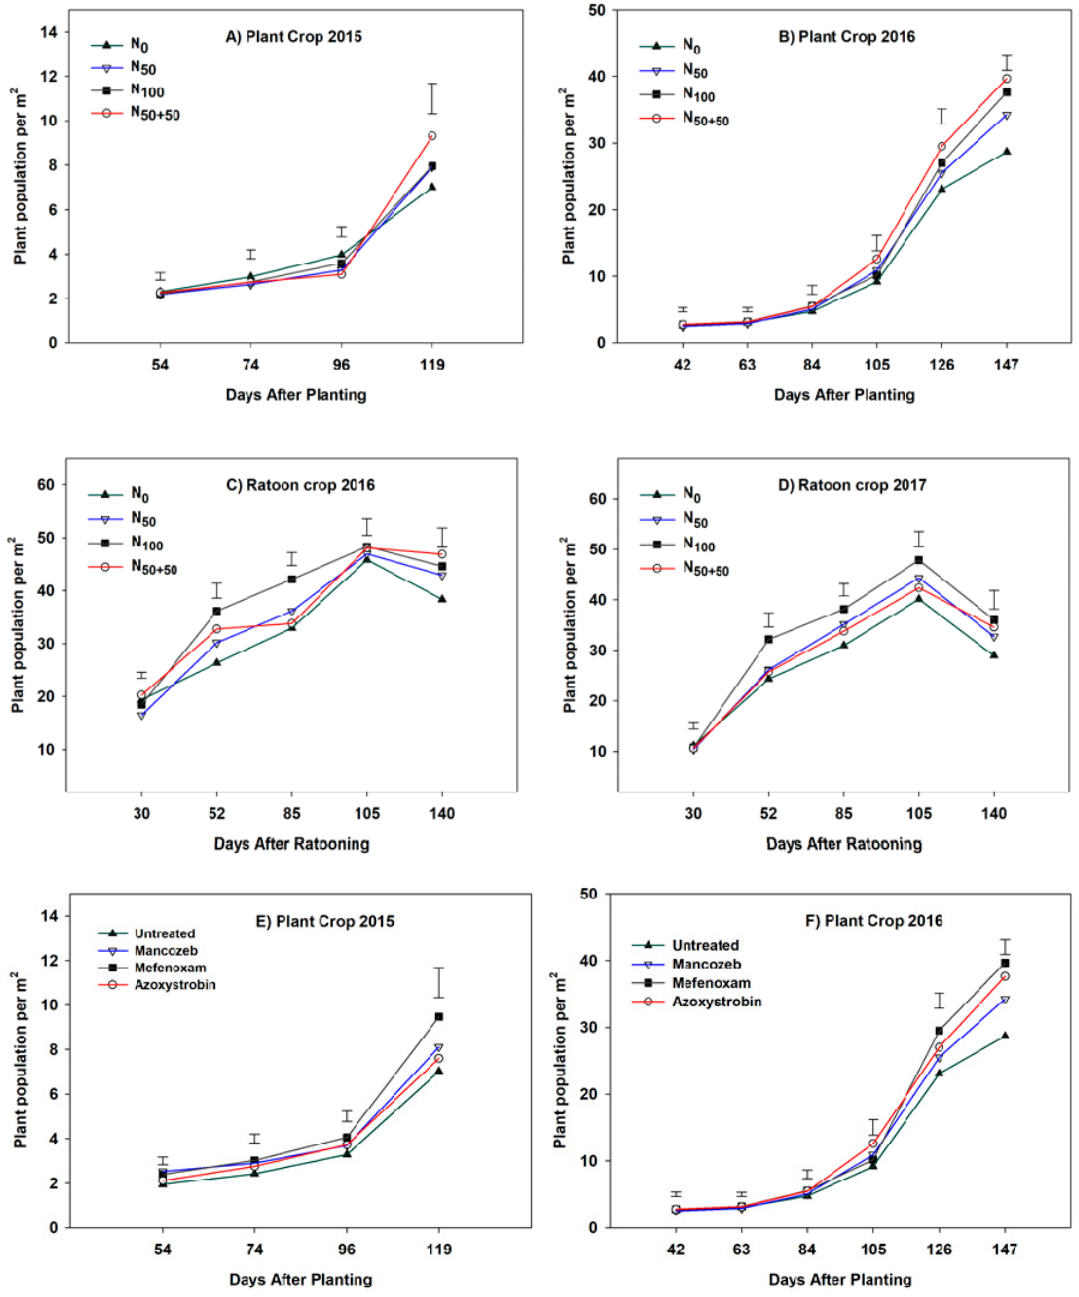
Figure 2. Sugarcane establishment and tiller dynamics as influenced by nitrogen fertilization and fungicides ( A ) plant crop 2015, ( B ) plant crop 2016, ( C ) ratoon crop 2016, ( D ) ratoon crop 2017; Fungicides in ( E ) plant crop 2015 and ( F ) plant crop 2016; Error bars represent standard error of the mean.